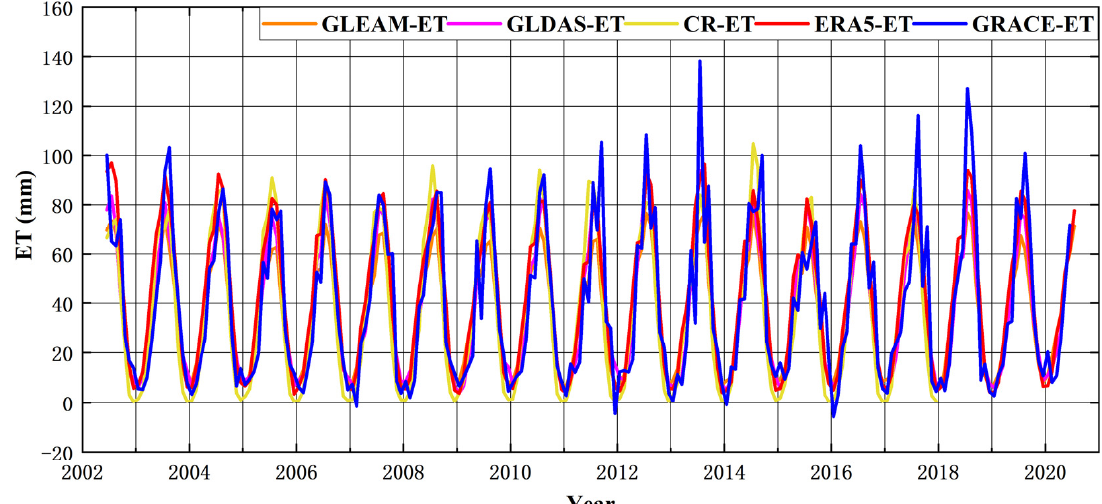
Figure 5. Comparison of five evapotranspiration (ET) time series in the Yellow River Basin. GLEAM—Global Land Evaporation Amsterdam Model; GLDAS—Global Land Data Assimilation Systems; CR—Complementary Relationship; ERA5—European Centre for Medium-Range Weather Forecasts Reanalysis 5; GRACE—Gravity Recovery and Climate Experiment.